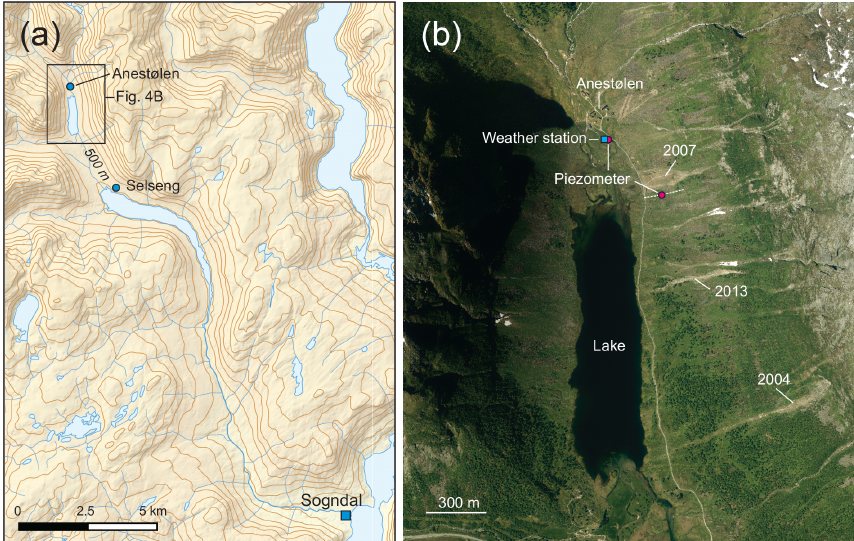
Figure 4. Map and aerial photo from 2018 of the site near Anestølen. (a) The contour interval is 100m. (b) The eastern slope is prone to debris slides and flows, and the most recent landslides are indicated with the year they occurred. There is a weather station including a piezometer located in the valley bottom (station no. 77.24.0) (https://sildre.nve.no, last access: 6 February 2019). We installed a piezometer in a borehole on the hillslope close to the southern slide scar of the 2007 slide. The dashed white line across the borehole shows the location of the profile in Fig. 5a © Kartverket/Geovekst (https://www.kartverket.no/, last access: 4 January